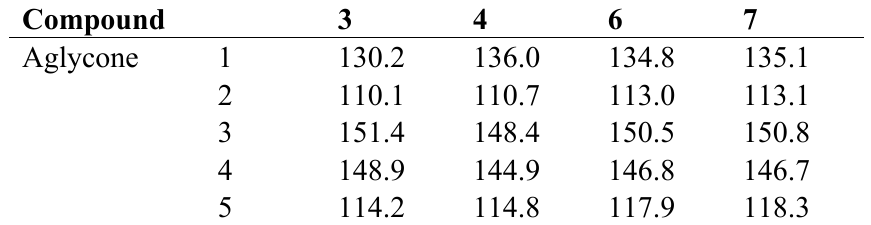
Table 1. 13 C chemical shifts of the glycosides 3 , 4 , 6 , and 7 in CD